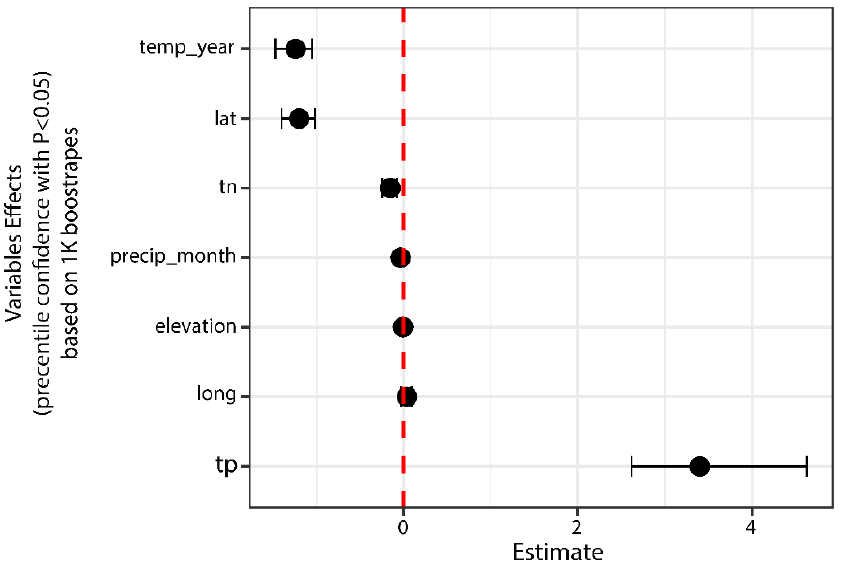
Figure 6. Generalized linear regression analysis.